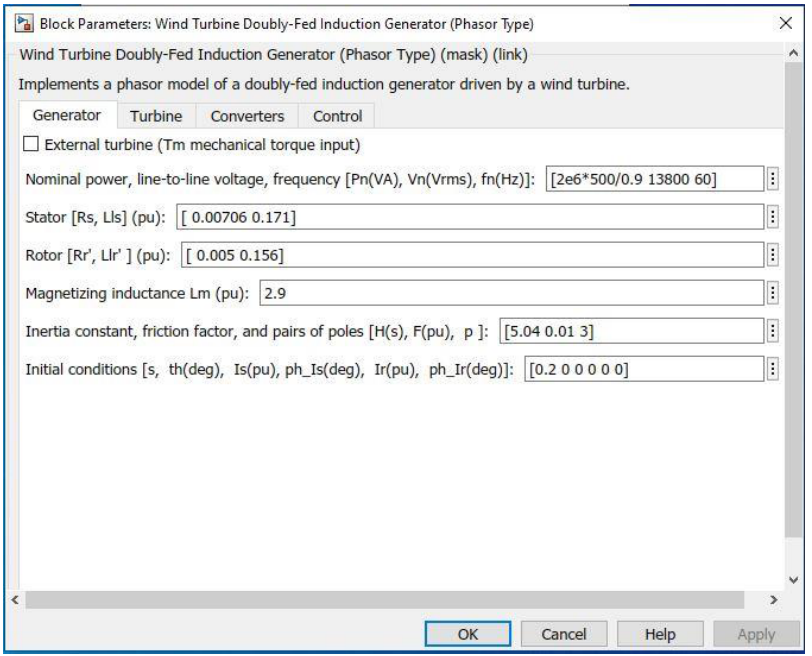
Figure 13. Parameters setting of 200 Load Block.